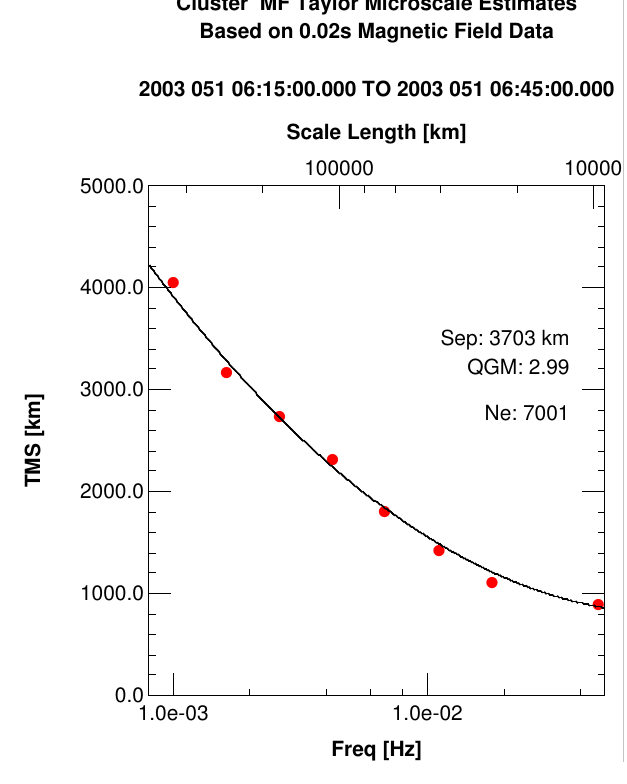
Fig. 4. λ T from magnetic field data as a function of the cutoff filter frequency and scale length (upper axis) showing the increase in the estimated λ T with increasing scale length and decreasing cutoff frequency.